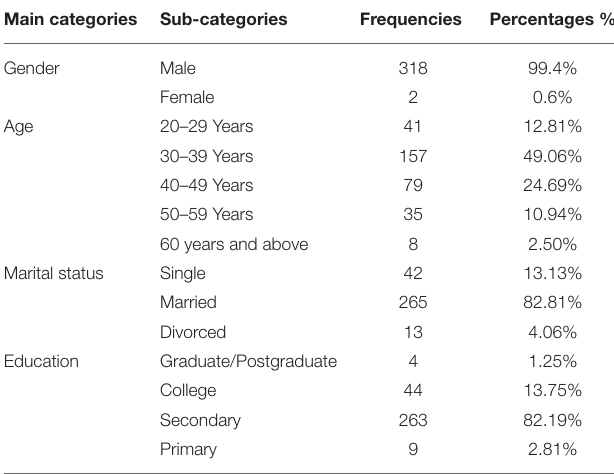
TABLE 1 | Instrument structure. TABLE 2 | Demographic information of the respondents ( n =